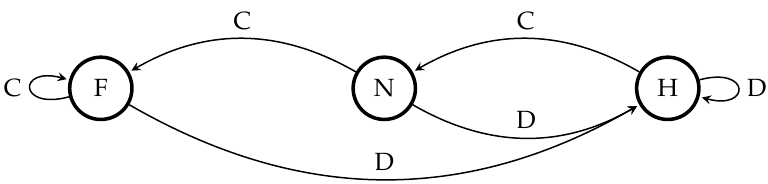
Figure 1. State transitions. The emotional player can transition between three states of mind and the transitions depend deterministically on the observed actions of the other